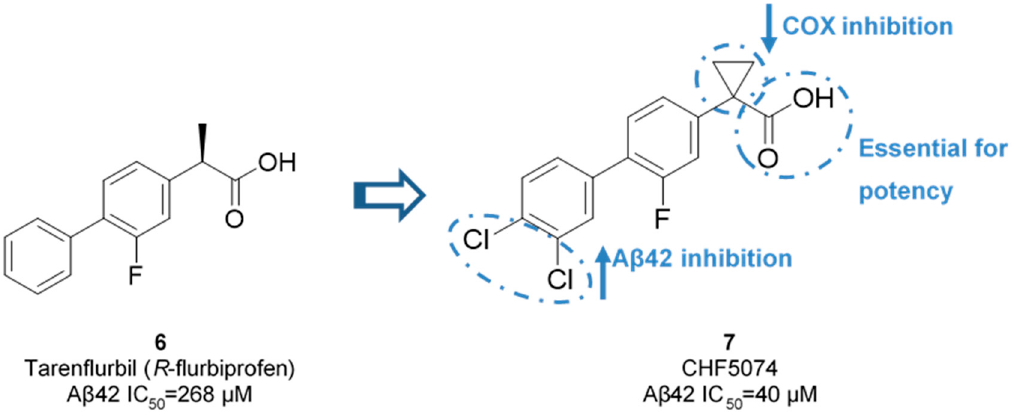
Figure 10. Improvement activity and selectivity of CHF5074 (7 ) against tarenflurbil ( 6